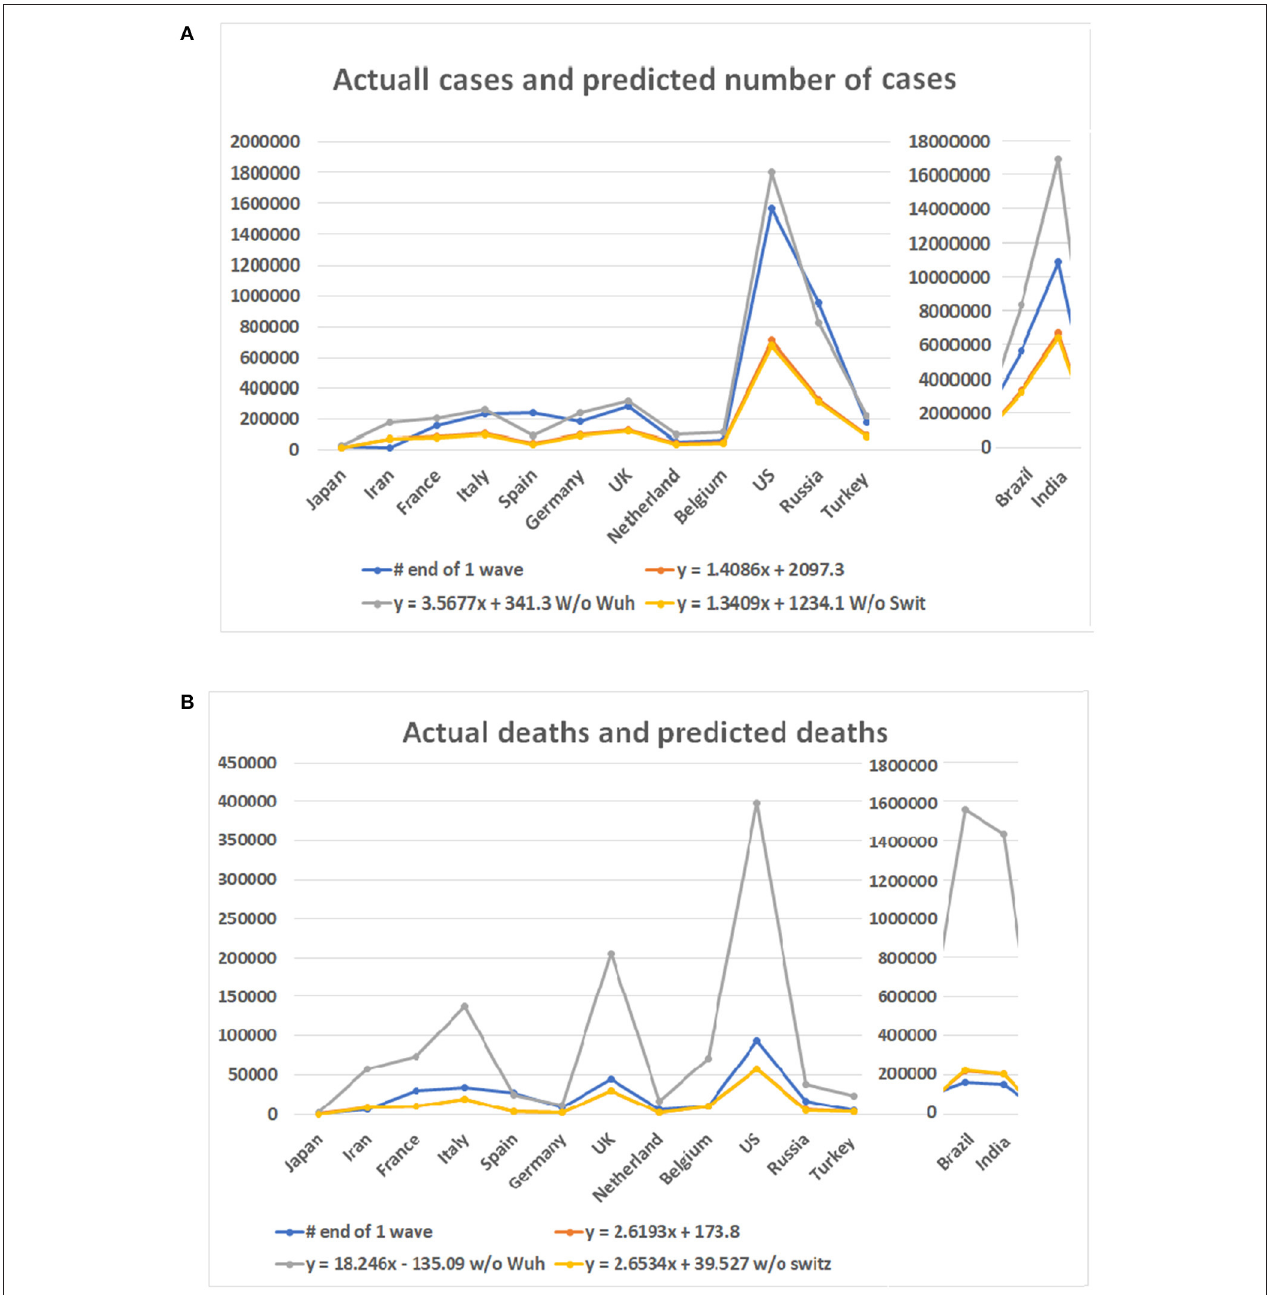
FIGURE 5 | Case numbers and mortality predicted for 14 countries and real numbers in the first wave of the disease. Numbers on Y bar are the case of death numbers. Color code: Blue for the real numbers. Red for the predicted numbers based on linear model. Gray color for the predicted numbers based on the linear model without data from Wuhan. Point for predicted numbers without data of Switzerland. (A) Predicted number of cases based on three linear models and real number of cases. (B) Death numbers predicted based on the linear models and reported numbers from 14 countries.